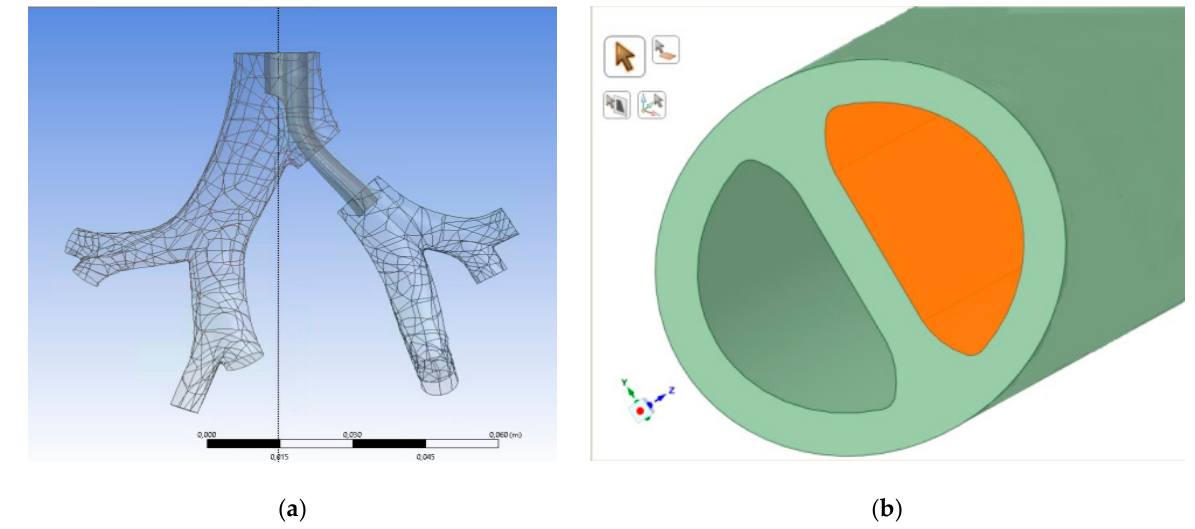
Figure 3. The location of the ETT end in the model of tracheobronchial tree and the cross section of the tube. ( a ) Computer model of ETT end position in the tracheobronchial tree; ( b ) cross section of double-lumen ETT computer model.